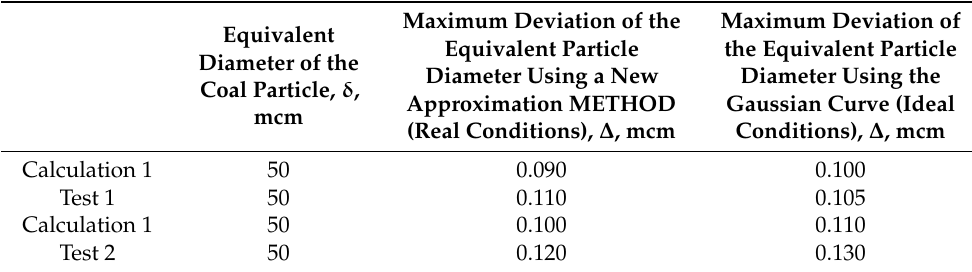
Table 2. Results of analytical calculations using the Gaussian curve, a new approximation method compared to experimental